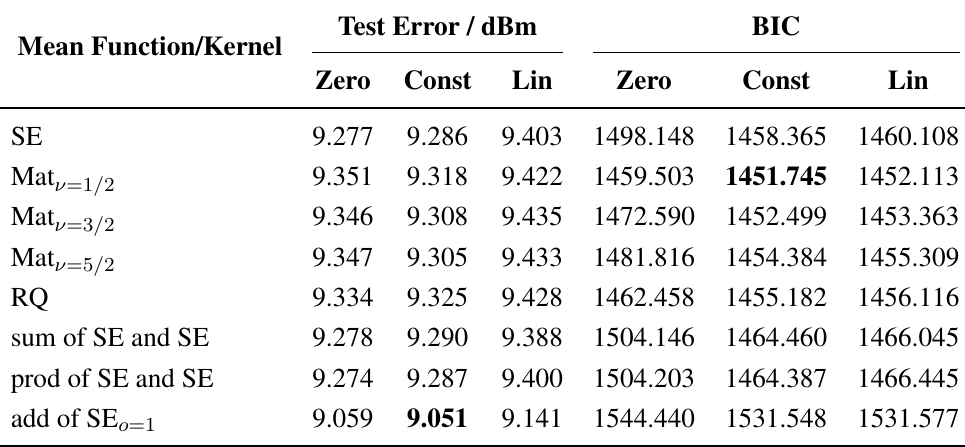
Table 4. Test error and BIC for different Gaussian process models trained with the Test-bed data. Model measures are averages over several access points and 10-fold cross-validation. The lowest values of each category are typeset in